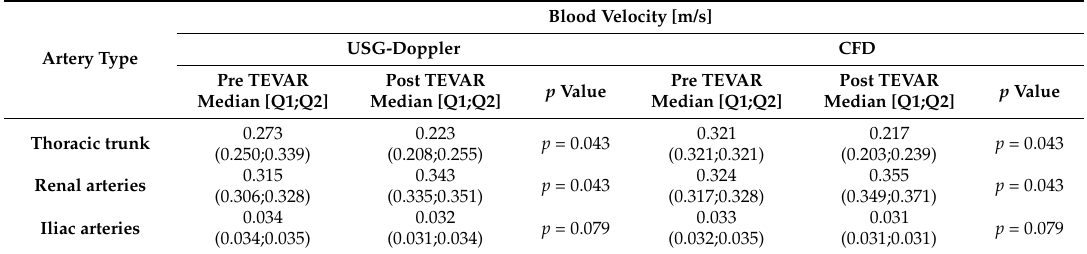
Table 3. Changes in blood velocity [m/s] pre- and post-TEVAR for USG-Doppler and CFD. Data are presented as the median (Q1;Q3). N = 5. p -values were calculated using the Wilcoxon Ranked Sign